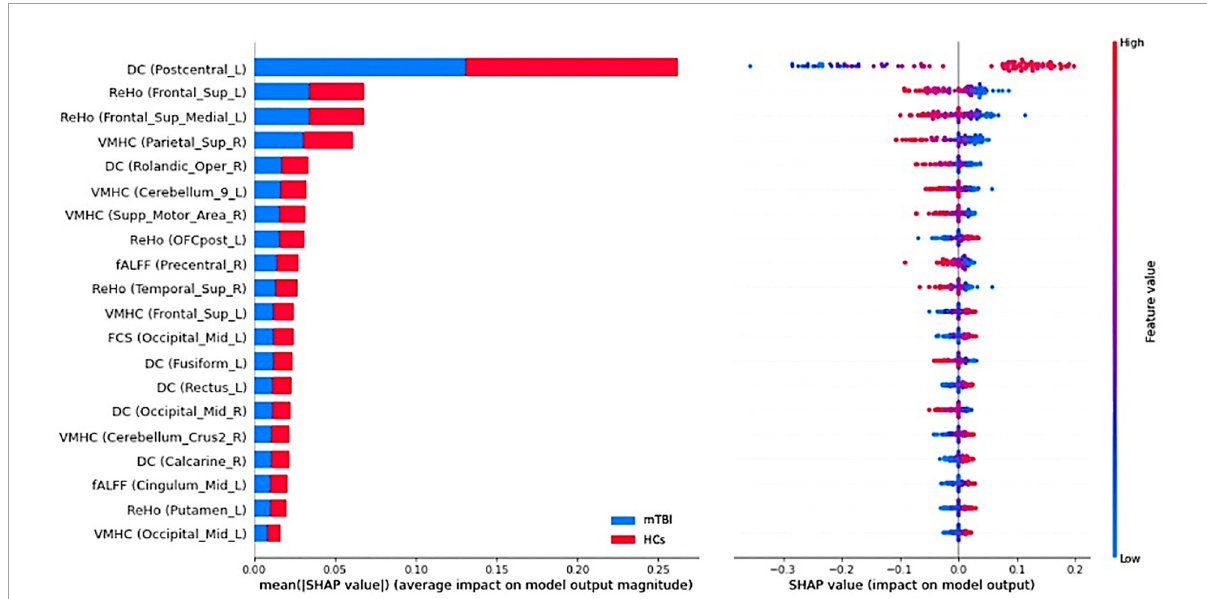
FIGURE6 Summary plot of the top 20 features with the most contribution to the model prediction of the local measures. (Left) The mean absolute Shapley Additive explanations (SHAP) values of the features. (Right) The SHAP values of features in every sample. Each line represents a feature, and each dot visualizes the SHAP value for one subject and corresponding feature. A positive SHAP value indicates an increase in the risk of predicting mild traumatic brain injury (mTBI) and vice versa. The vertical axis represents both the features, ordered by the mean absolute SHAP values and their distribution.